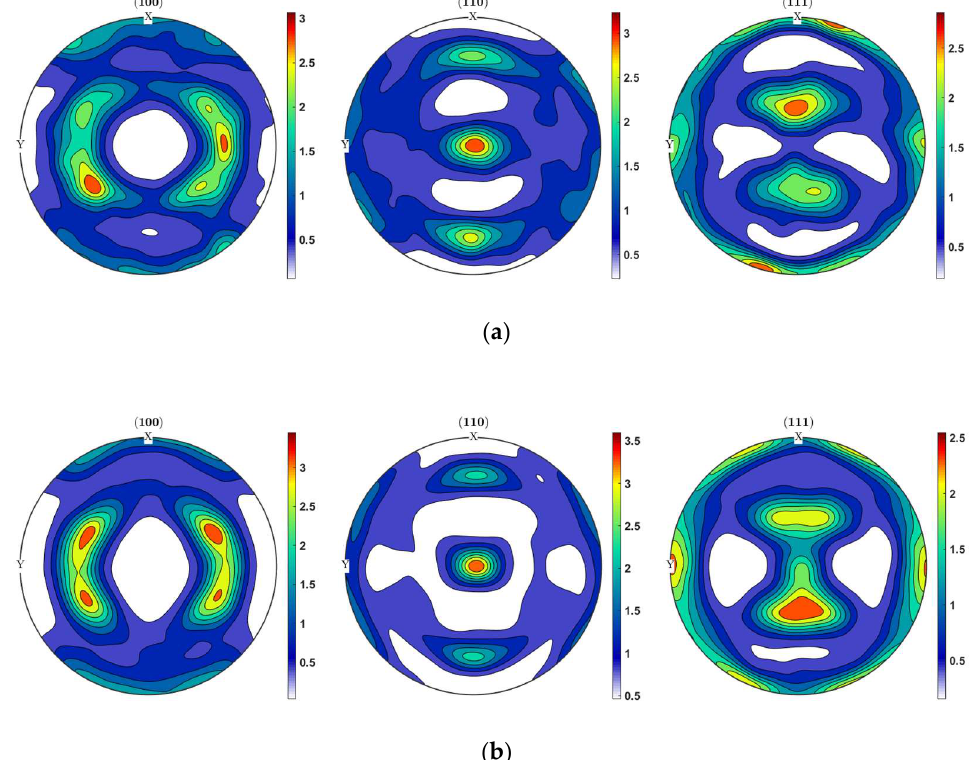
Figure 1. Pole figures of the iron face centred cubic orientations with stereographic projection of the upper hemisphere with m3m symmetry for ( a ) the 50 % deformed sample (792127 data points) and ( b ) the 70 % deformed sample (70977 data points).